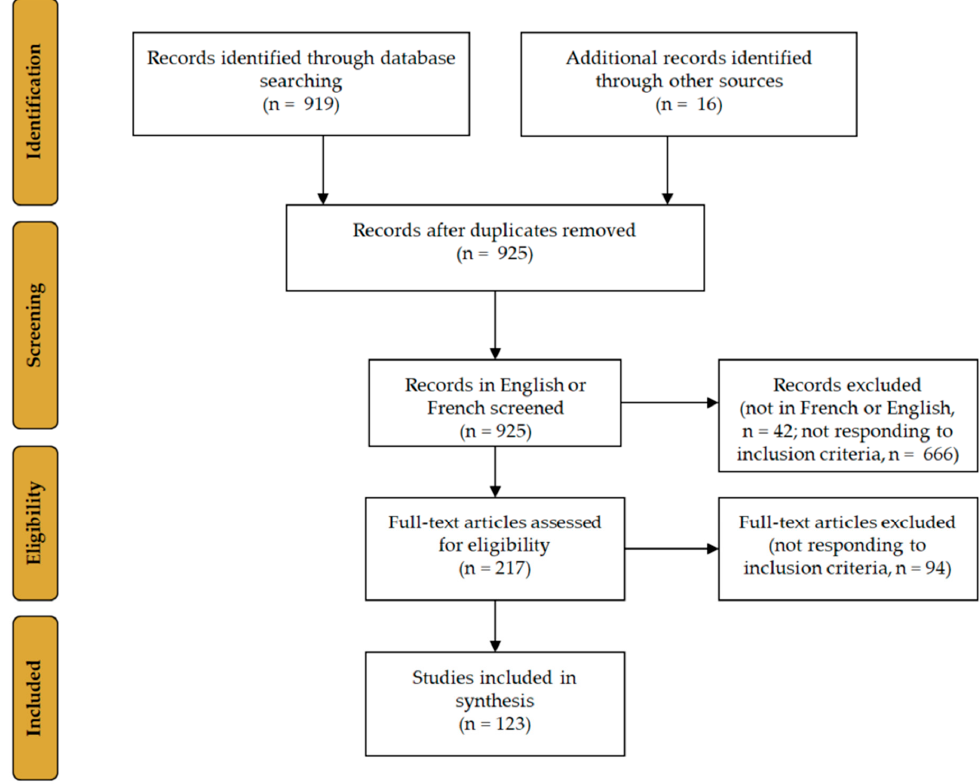
Figure 2. Study flow diagram (PRISMA) showing the flow of information through the different phases of the systematic review. Remote Sens. 2020 , 12 , x FOR PEER REVIEW